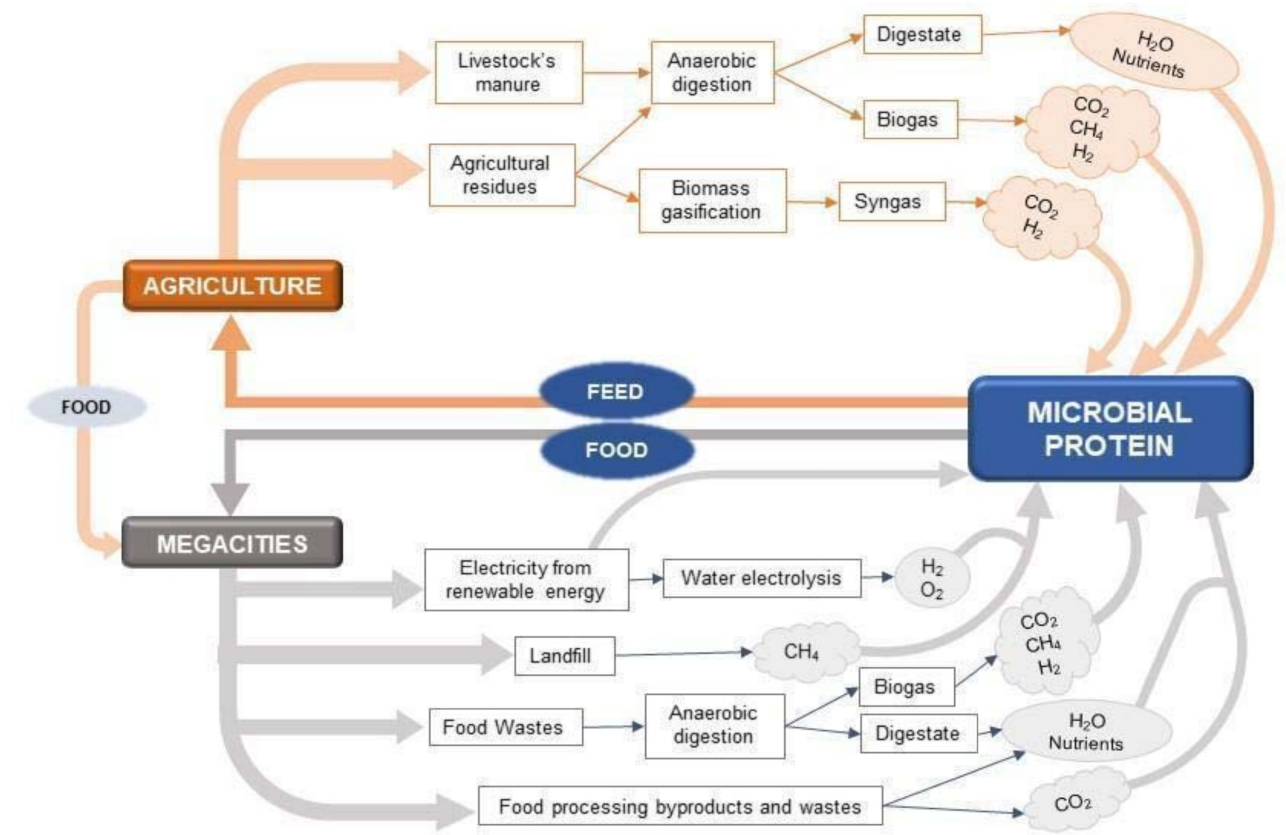
Figure 1. Fluxes of nutrients, water, electric and chemical energy, organic and inorganic carbon from agriculture (above) and megacities (below) wastes to microbial protein